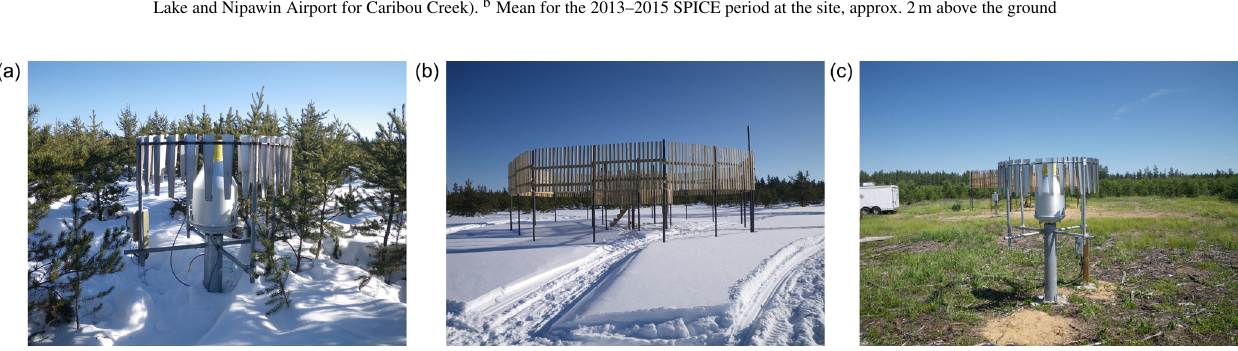
Figure 4. Precipitation gauge installations at the Caribou Creek SPICE site: (a) bush-shielded Geonor T-200B with Alter shield, (b) DFAR with Geonor T-200B in clearing, and (c) Alter-shielded Geonor T-200B in